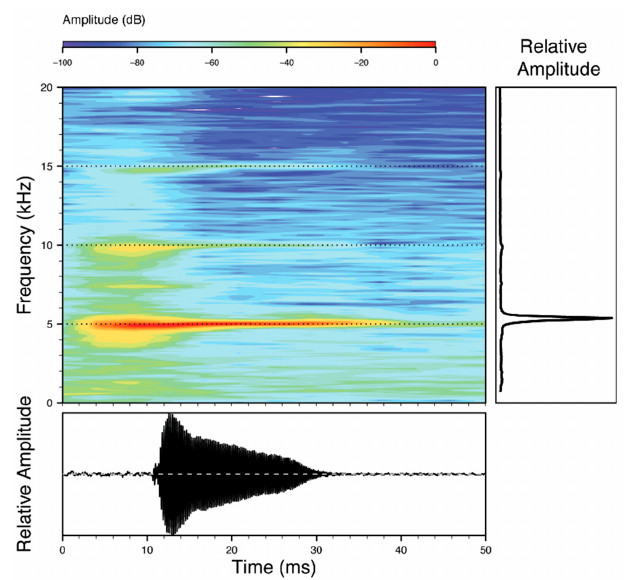
Figure 182. Call of Nymphargus siren , MZUTI 765, recorded at trail between Oyacachi and El Chaco, 1645 m, Napo province, Ecuador. Air temperature = 15 ◦ C. Tadpole: Not described.